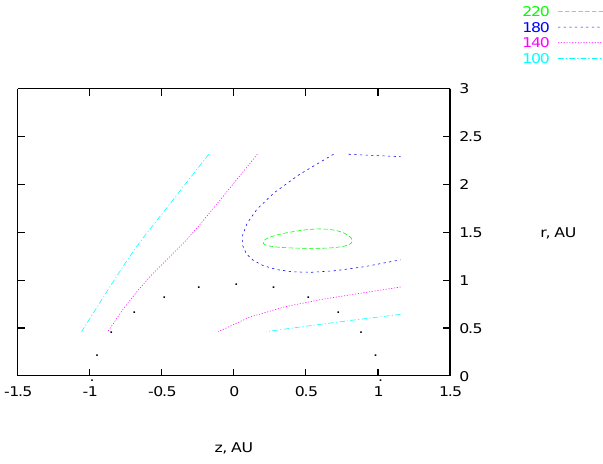
Fig. 1. Isodensity contours in the r − z plane. Contours are asso- ciated to linestyles, corresponding to density values in cm − 3 . The Earth’s orbit is shown by the dotted semi-circle. Values of the in- put parameters are: n i = 100cm − 3 , V i = 26km/s, T i = 100K. β 0 = β φ ,µ = 0 .